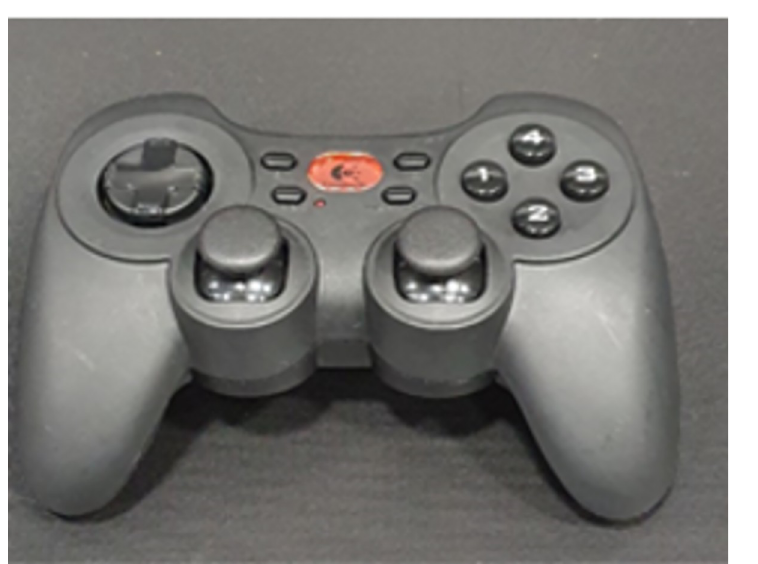
Fig 3. Two-handed game controller used to carry out